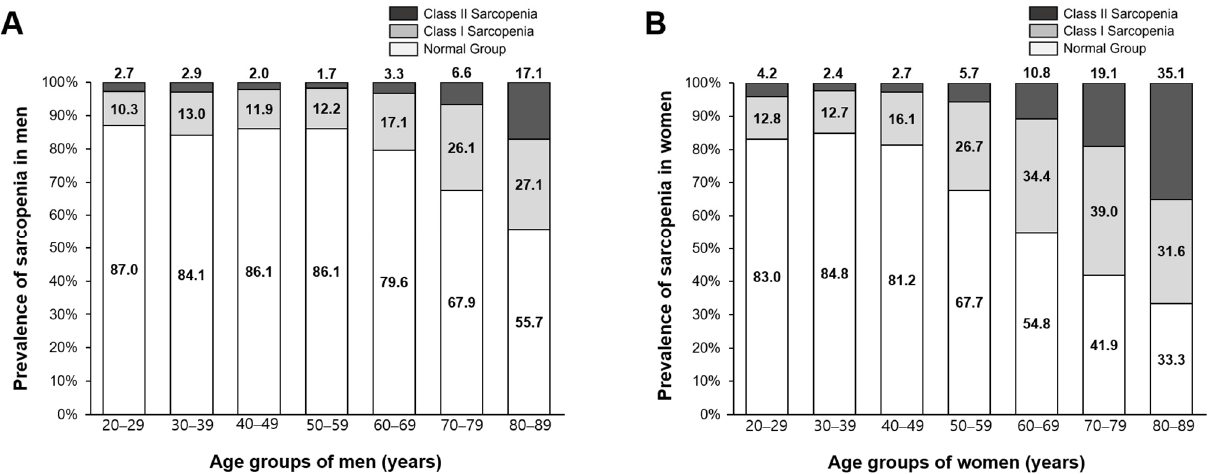
Figure 3. Prevalence rates for sarcopenia status across age groups (20–29, 30–39, 40–49, 50–59, 60–69, 70–79, 80–89 years) for ( A ) men and ( B ) women. SMI = skeletal muscle mass index.